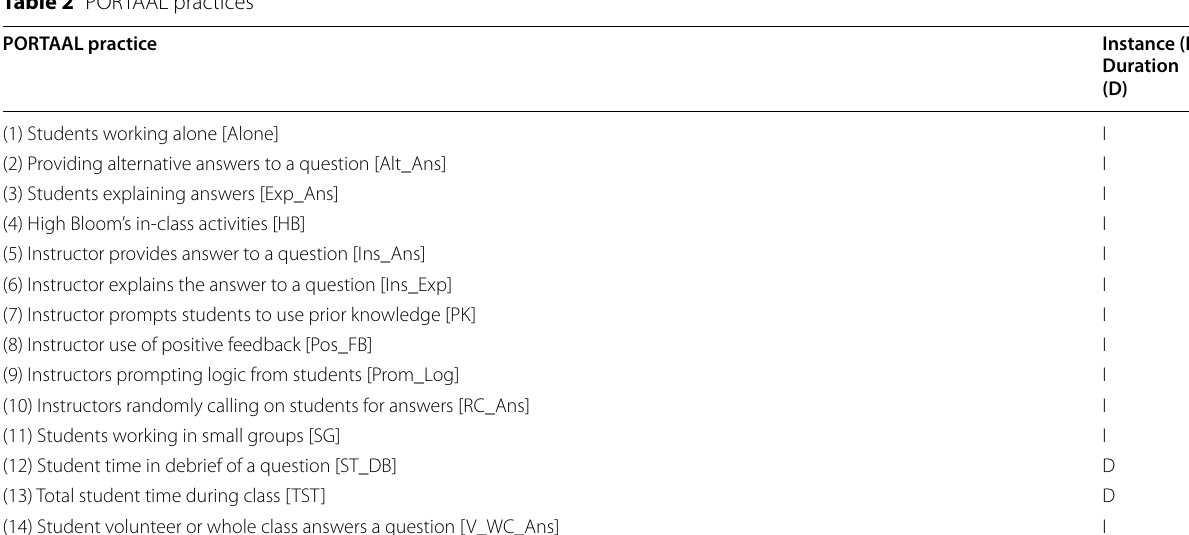
Unit of instance: n times. Unit of duration: minutes . Code names of each practice are included in brackets